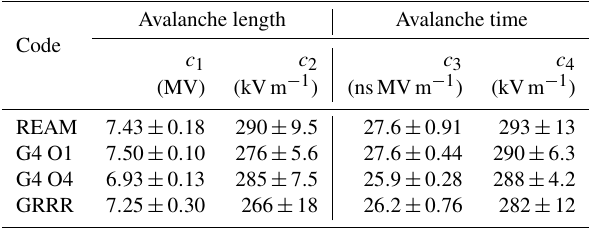
Figure 4. (a) Avalanche multiplication time as function of ambient electric field for each of the codes included in this study. (b) The rel- ative difference of all other models with respect to REAM. Table 1 indicates the values of the fit parameters. Table 1. Values of the parameters of the fits (with 95% confidence intervals) for the simulations’ data for avalanche scale in space and time, using the models described by Eqs. (16) and (17). See Figs. 3 and 4 for the corresponding